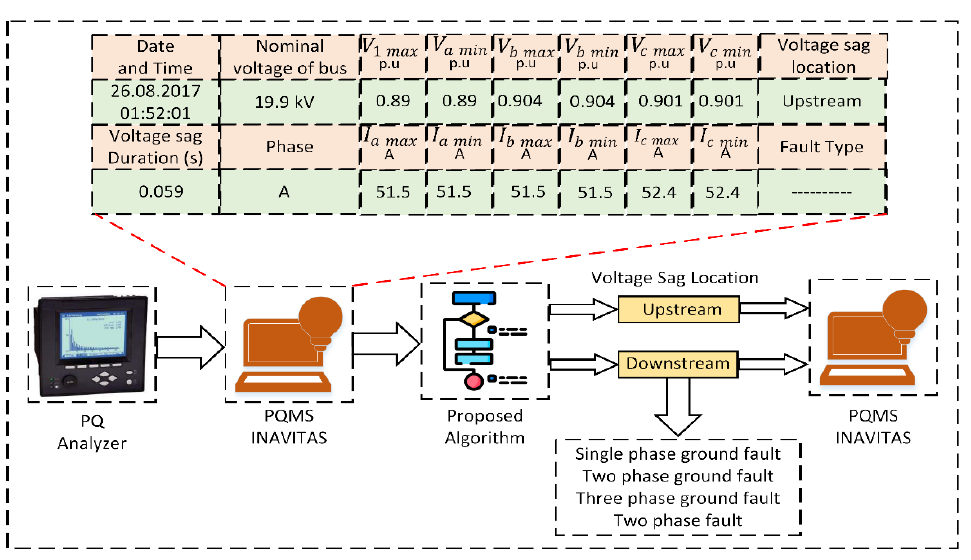
Figure 1. General overview of the proposed method.